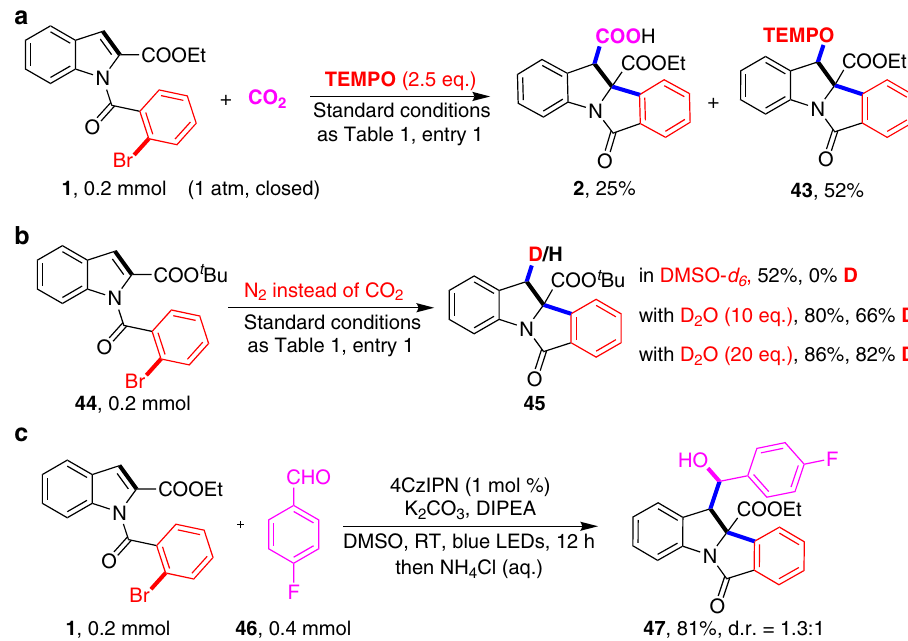
Fig. 6 Preliminary mechanistic studies. a Trapping experiment by radical scavenger 2,2,6,6-tetramethyl-piperidinyloxyl (TEMPO), supporting that radical process might be involved. b Isotopic labeling experiments in DMSO- d 6 or in the presence of different amounts of deuterated water, suggesting that benzylic anion was involved. c 4- fl uorobenzaldehyde was used as an electrophile instead of CO 2 , further indirectly con fi rming the formation of benzylic anion intermediate.